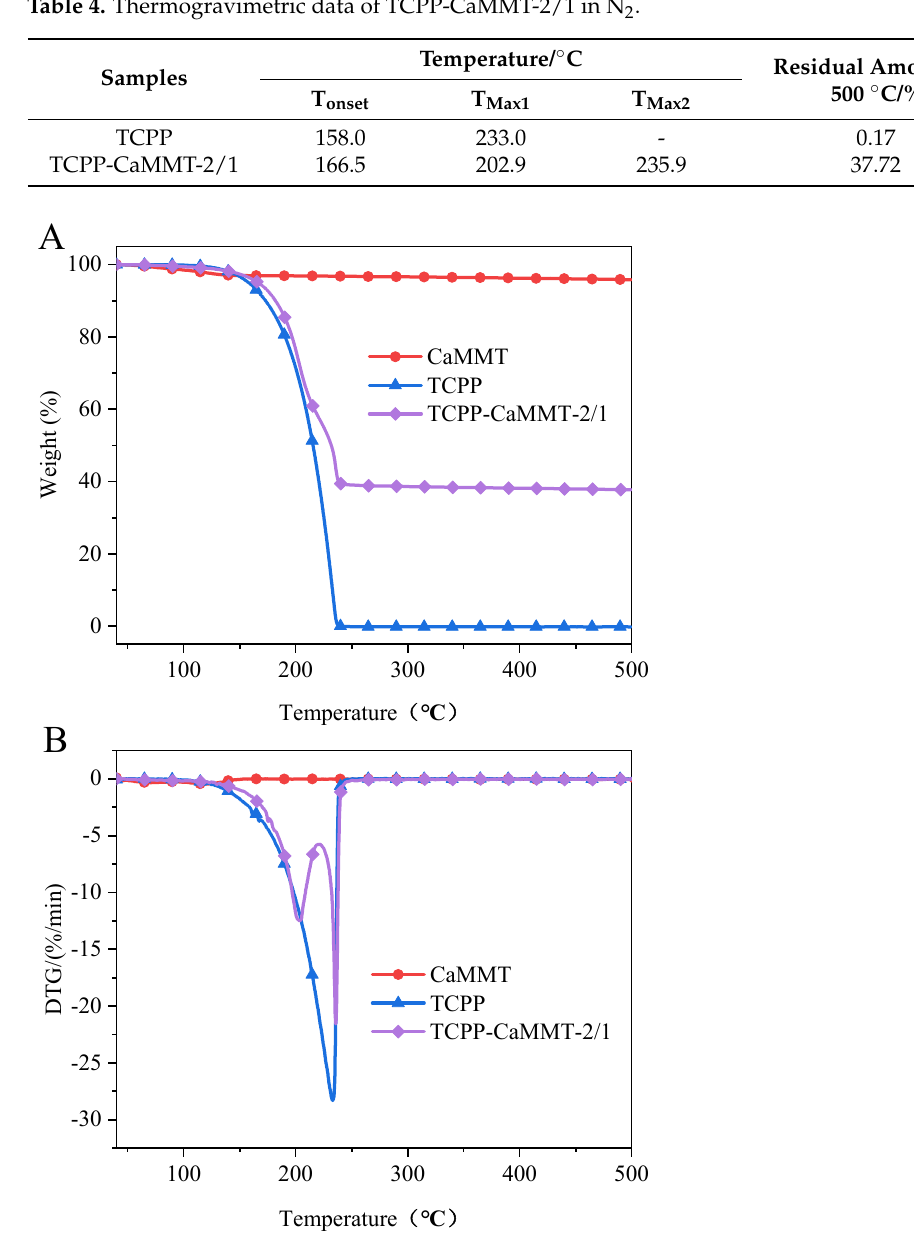
Figure 9. TG ( A ) and DTG ( B ) curves of TCPP-CaMMT-2/1 in N 2 .